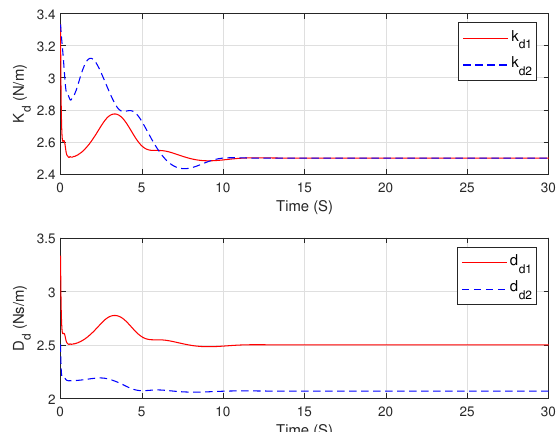
Figure 4. The desired robot stiffness and damping.